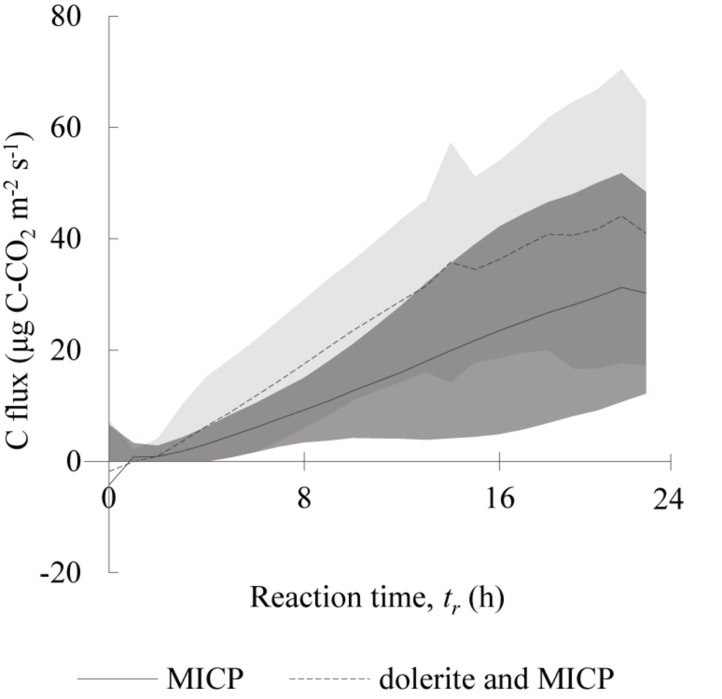
Average CO2 fluxes during 24 h reaction time of soil column treated with traditional (MICP), and for soil column containing dolerite fines added to the MICP treatment (dolerite and MICP). The first and second treatments were excluded from the computed average for both treatments for comparison purposes and to remove the initial near-zero CO2 fluxes not observed in posterior treatments in the soil column containing dolerite fines. Dark and light grey shaded areas indicate ± two standard deviations for MICP and dolerite and MICP, respectively.